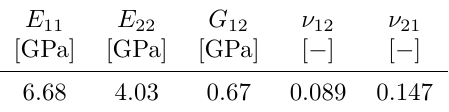
Table 2. Equivalent elastic properties for RVE.